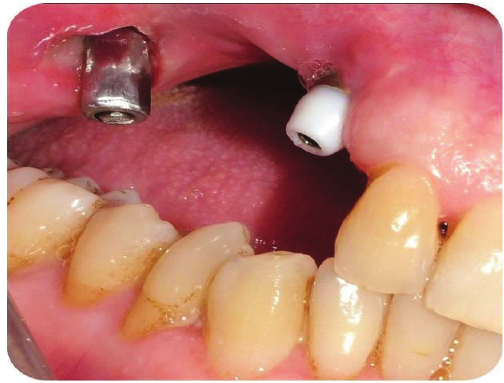
Figure 6: Intraoral view during osteointegration period.